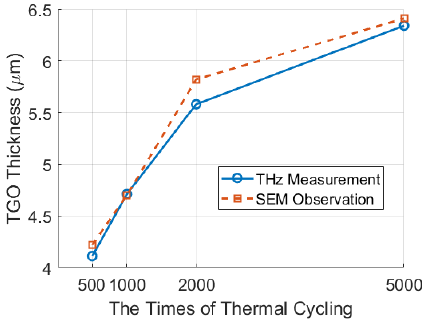
Figure 7. The thickness of the TGO layers after different thermal cycles.